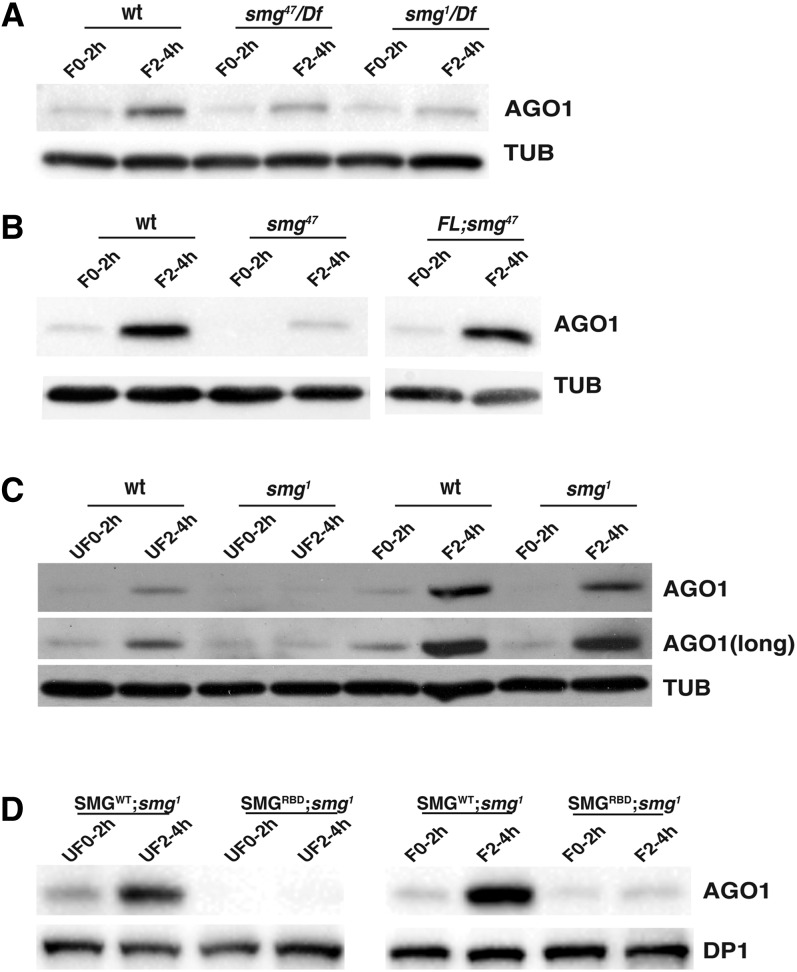
AGO1 protein levels are dramatically reduced in smg mutant embryos. Western blot analysis of SMG protein expression with either tubulin or DP1 as loading controls. (A) AGO1 levels in smg1/Df(3L)Scf and smg47/Df(3L)Scf embryos are reduced relative to wild-type in 2–4 hr embryos. (B) A full-length smg transgene (FL) rescues AGO1 expression in a smg47 mutant background. (C) AGO1 levels are also reduced in smg1/Df(3L)Scf 2–4 hr unfertilized eggs relative to wild-type. (D) RNA binding by SMG is necessary for AGO1 expression. The genotype of the females was: UASP[SMGWT or SMGRBD]; smg1/P[GAL4::VP16-nos.UTR] smg1. The SMGWT transgene rescued expression of AGO1 in both smg1 unfertilized eggs and embryos, whereas the SMGRBD transgene (Semotok et al. 2008) did not rescue smg1. AGO1, Argonaute 1; SMG, Smaug; TUB, tubulin; wt, wild type. UF0-2h, 0-2 hr unfertilized eggs; UF2-4h, 2-4 hr unfertilized eggs; F0-2h, 0-2 hr embryos; F2-4h, 2-4 hr embryos.